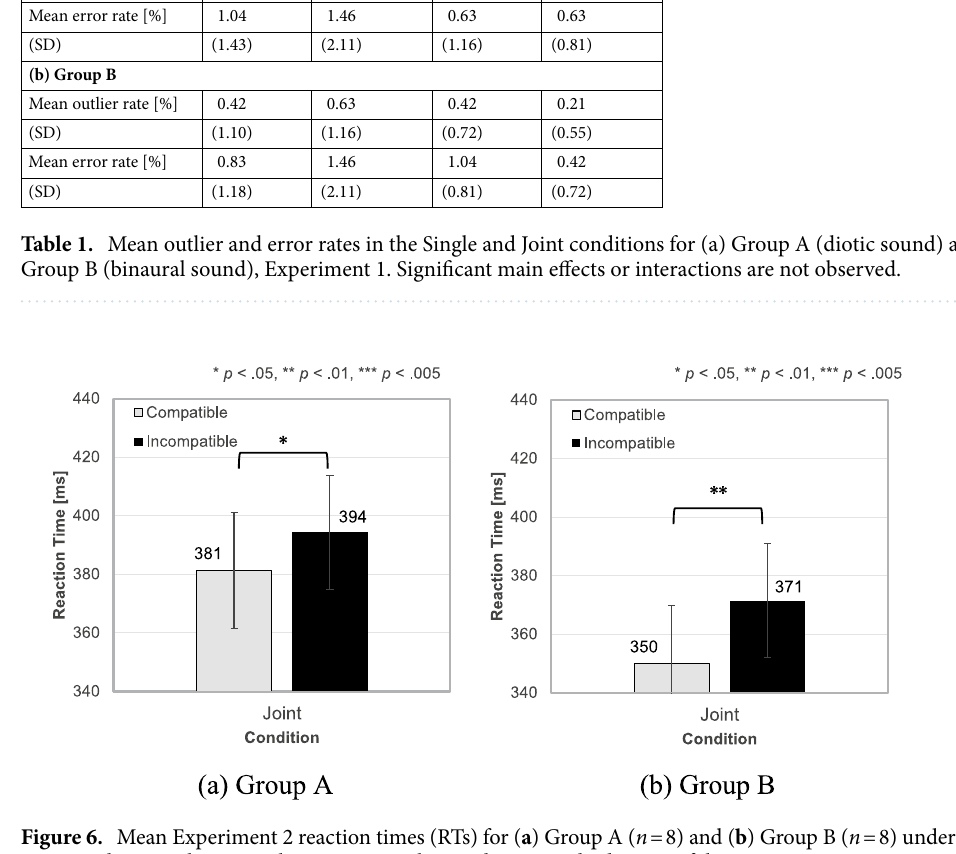
Figure 6. Mean Experiment 2 reaction times (RTs) for ( a ) Group A ( n = 8) and ( b ) Group B ( n = 8) under the Joint condition with an actual partner. Error bars indicate standard errors of the means.